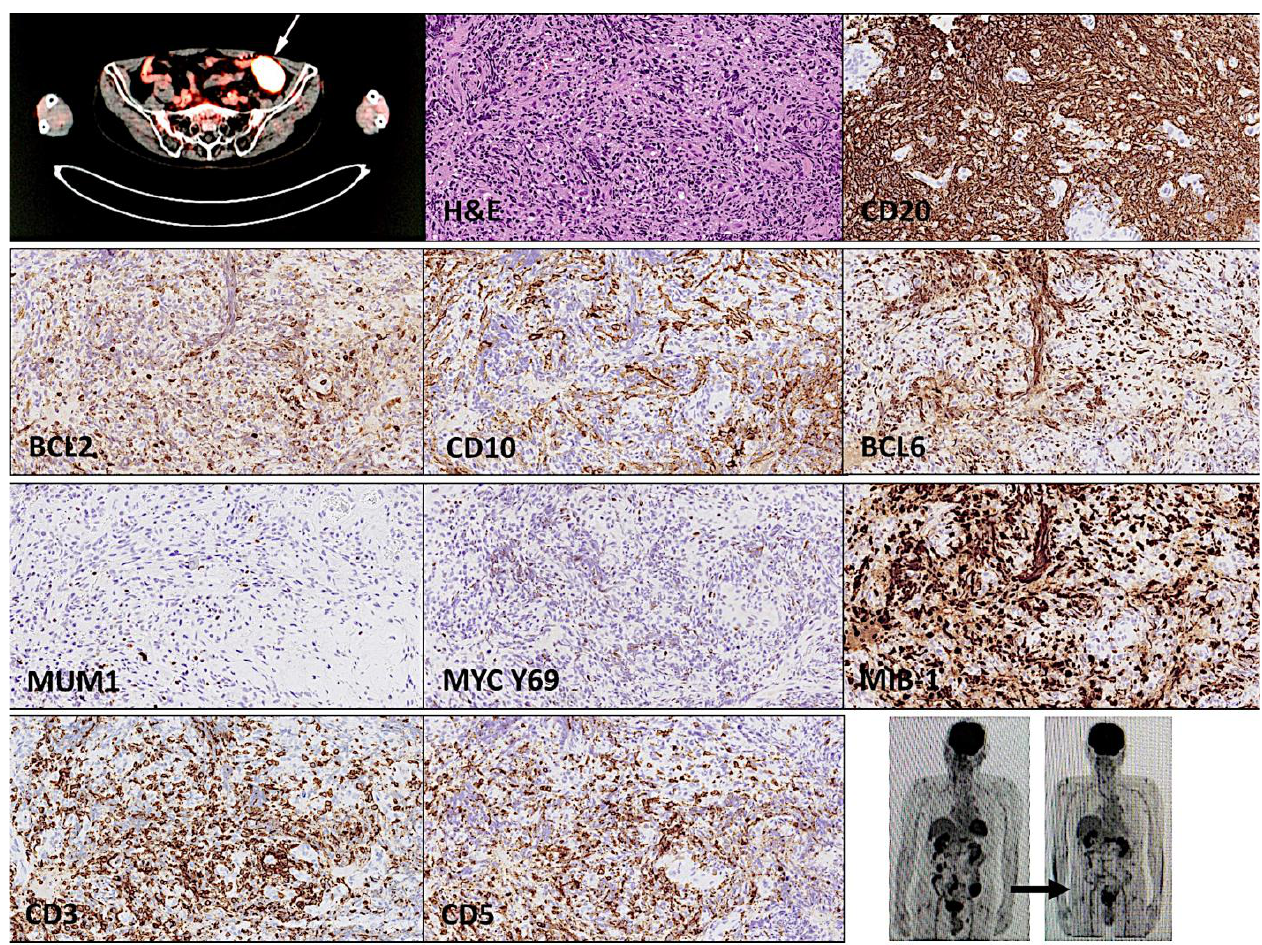
Figure 4. Histological features and mutational profile of the sigmoid mass. The sigmoid mass had the same immunophenotype as the right supraclavicular (lymph) node enlargement. It was CD20- positive, BCL2-positive, CD10-negative, BCL6-positive, and MUM1-negative. The expression of MYC was moderately positive, and had a high proliferation MIB-1 index. Infiltration of the immune microenvironment with CD3- and CD5-positive T lymphocytes was abundant. After treatment, the sigmoid mass shrunk.